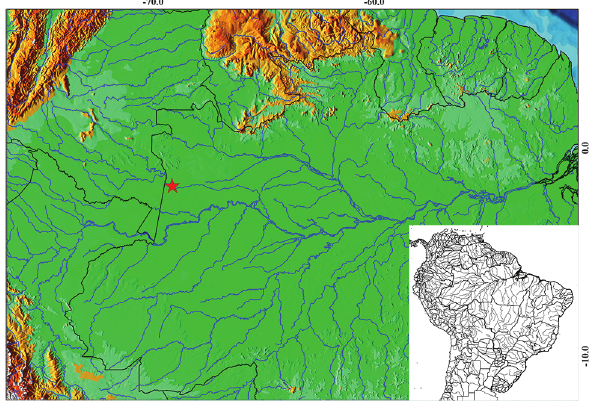
Fig. 4. Distribution map of Boehlkea weitzmani in the rio Japurá basin, Amazon State, Brazil.